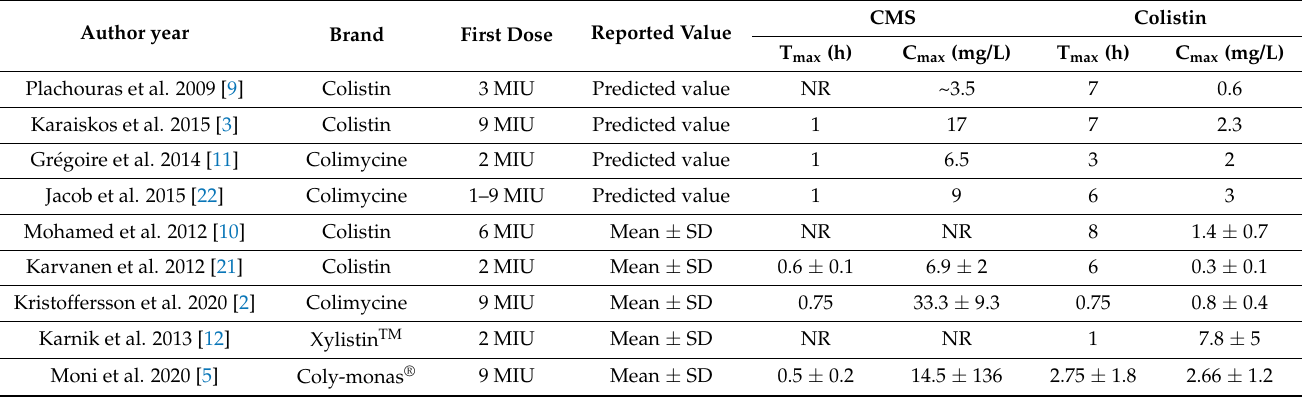
Table 2. Comparison of CMS and colistin concentration in plasma after administration of a first dose of